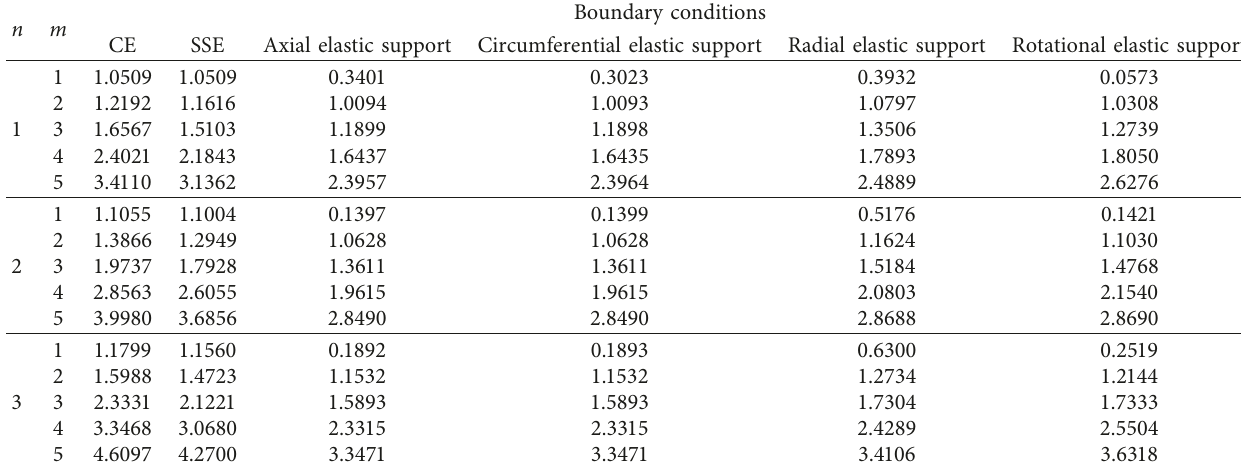
Table 9: Nondimensional frequency parameter of uniform 30 degrees spherical cap with different edge conditions.